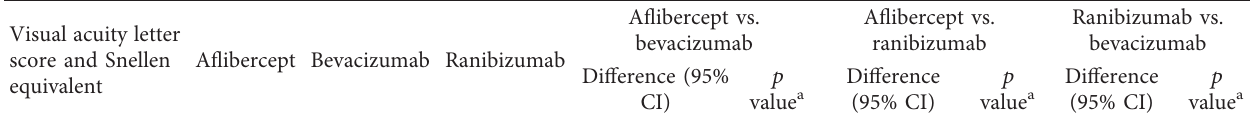
Table 2: Overview of the visual acuity outcomes of the Protocol